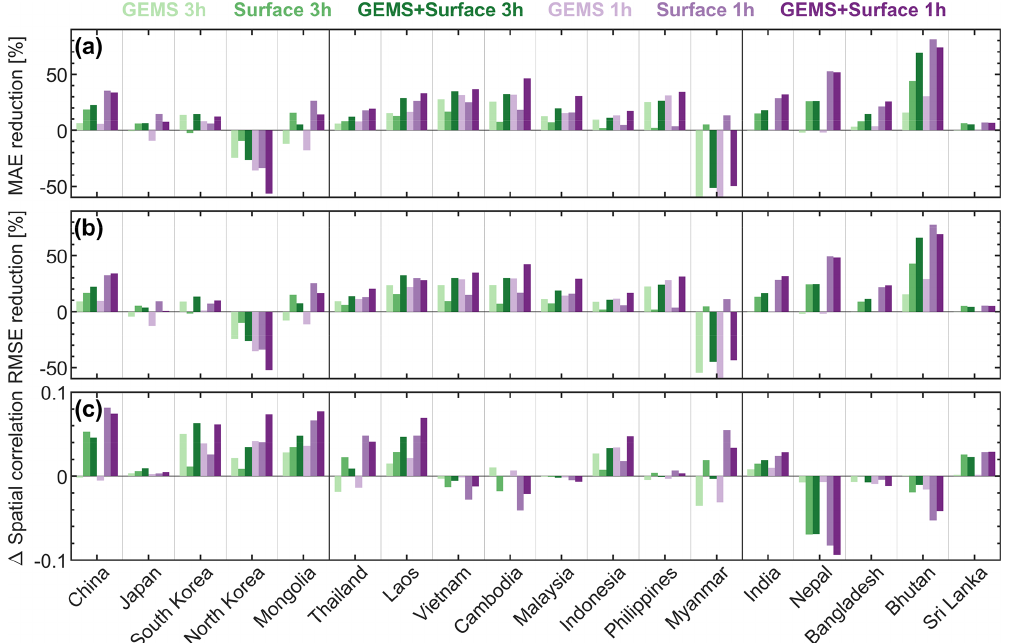
Figure 5. The MAE reduction (a) , RMSE reduction (b) , and the difference in the spatial correlation coefficient (c) of simulated surface ozone between the assimilation run and the control run relative to the nature run for June 2020 in 18 Asian